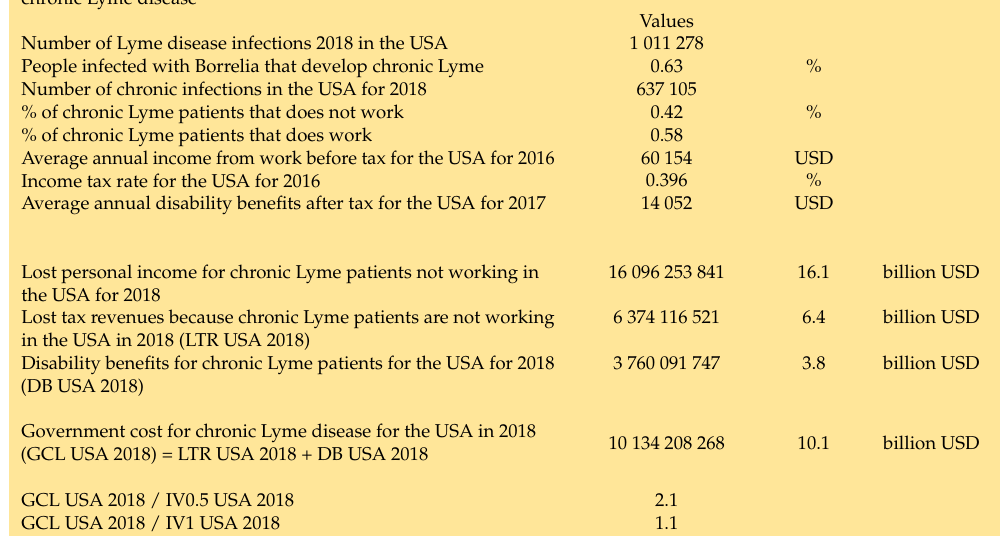
Table 14. Government cost for chronic Lyme disease for Europe for 2018 if governments do not finance IV treatment with antibiotics for chronic Lyme